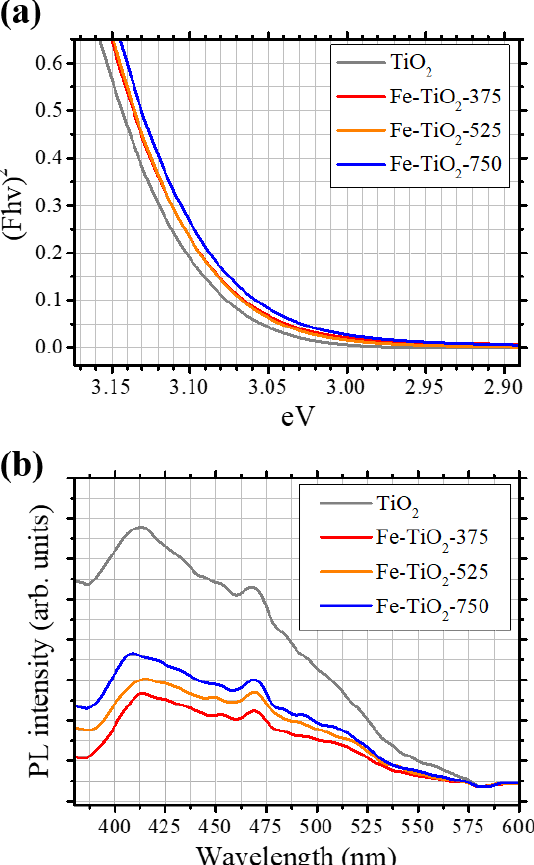
Figure 3. Results of UV diffuse reflectance spectrophotometry (UV-DRS) and photoluminescence (PL) analyses. ( a ) Kubelka–Munk plots of the results of UV-DRS measurements with TiO 2 and Fe-TiO 2 -375, -525, and -750. ( b ) PL signal measured with TiO 2 and Fe-TiO 2 -375, -525, and -750 samples.